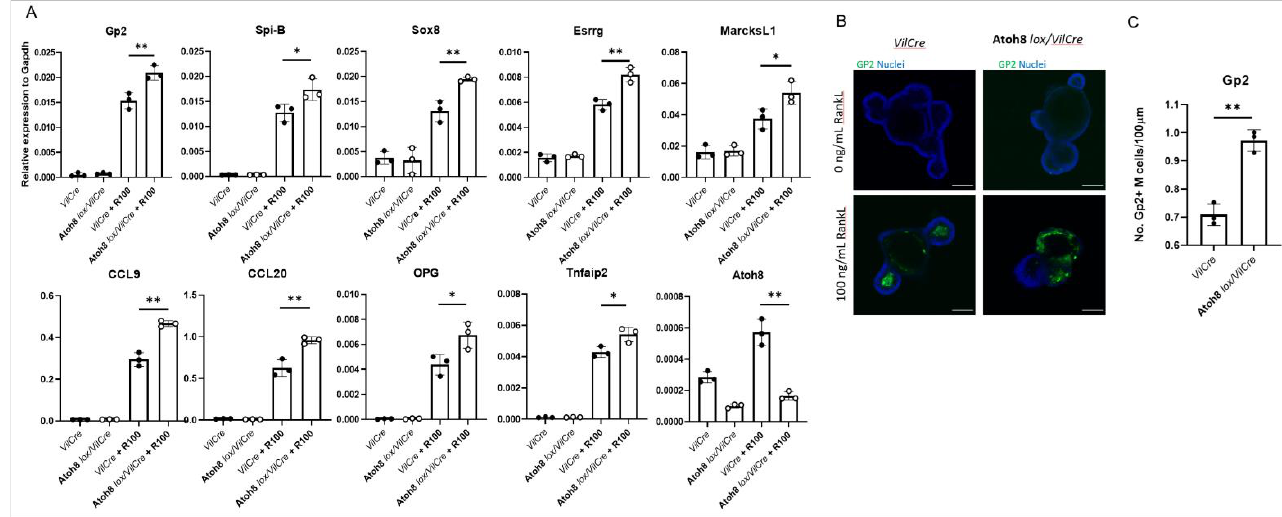
Figure 4. Increase in M cell maturation in Atoh8 lox/VilCre results from epithelium-intrinsic defect. ( A , B ) Organoids from small intestinal crypts of Atoh8 lox/VilCre and VilCre mice were cultured with or without RANKL for 3 d. (A) qPCR analysis of M cell-associated genes expressed in the organoid cultures. Values are presented as the mean ± SD; **, p < 0.01; *, p < 0.05; n.s., not significant; unpaired two-tailed Student’s t -test, n = 3. Data are representative of two independent experiments. ( B ) Immunostaining images for GP2 (green) on organoids. Bars, 100 μ m. ( C ) The number of Gp2+ M cells and Sox8+ M cells per length epithelium of organoids were compared between VilCre and Atoh8 lox/VilCre treated organoids ( n = 3). Images are representative of three independent experiments.